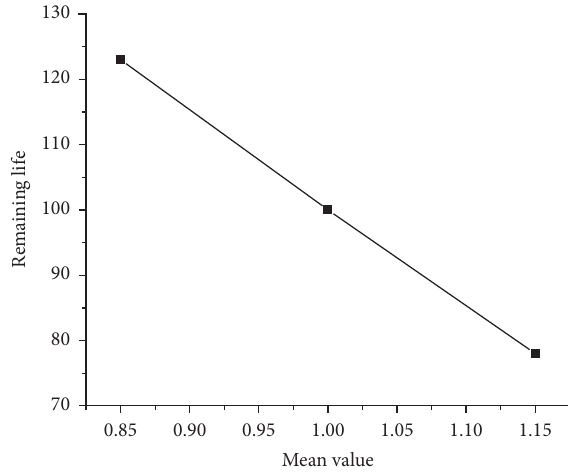
Figure 10: Influence of coefficients of variation of live load.